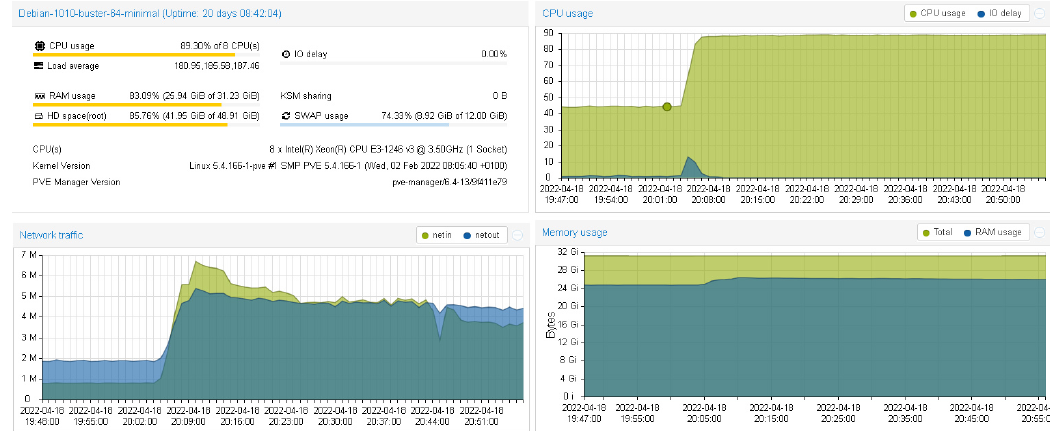
Figure 2: Example of using an academic cloud resources.